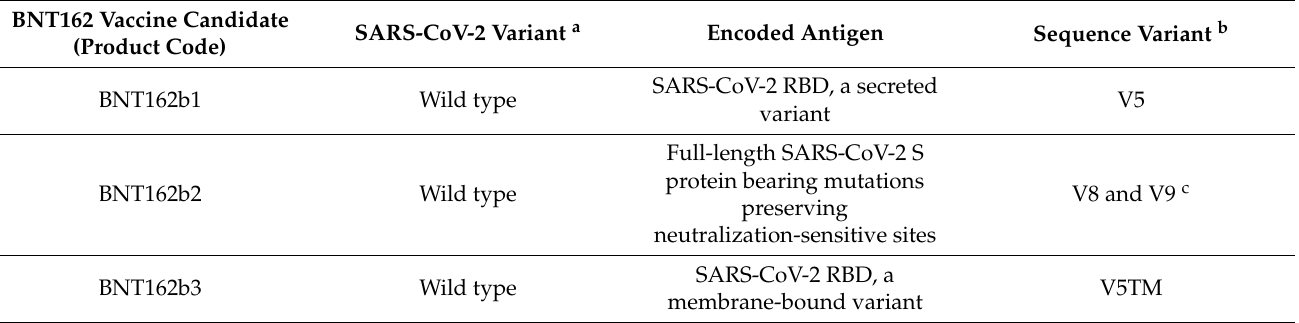
Table 1. Description of BNT162b modRNA vaccine